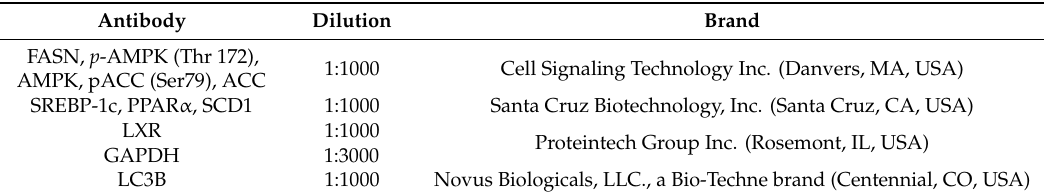
Table 1. List of